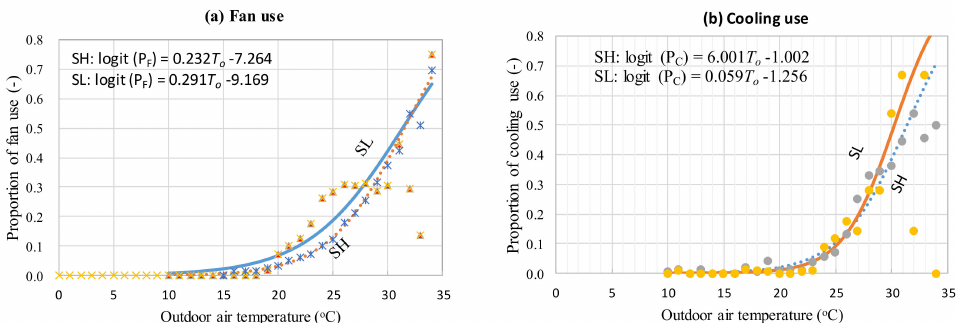
Figure 11. Relationship between fan use or cooling use and outdoor air temperature for higher and lower groups in summer: ( a ) Fan use and ( b ) Cooling use.